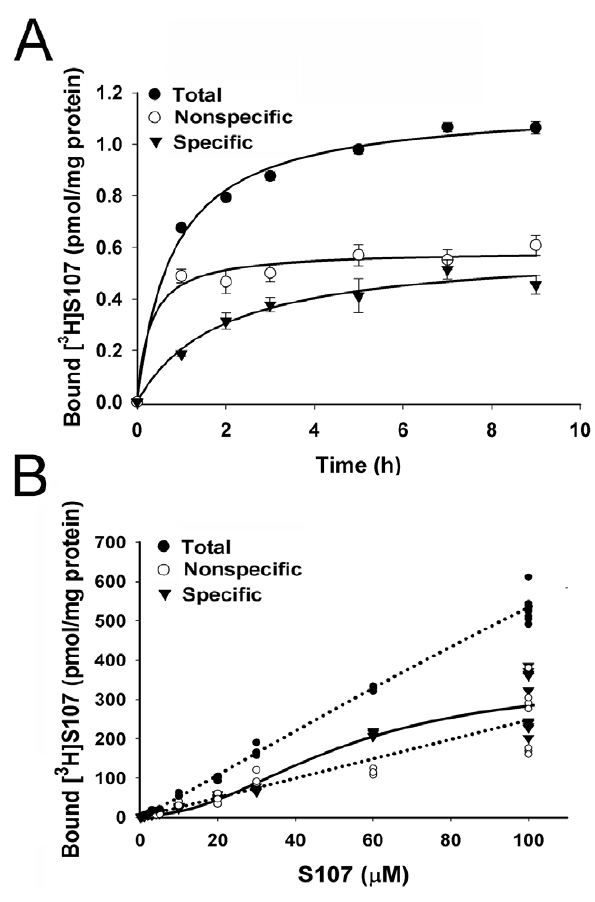
Figure 1. [ 3 H]S107 binding to SR vesicles. (A) Time course of total, nonspecific and specific [ 3 H]S107 binding to SR vesicles incubated with 0.2 m M [ 3 H]S107 in 0.25 M KCl, 20 mM imidazole, pH 7.0, 50 m M free Ca 2 + and protease inhibitors for 1 to 9 h at 24 u C. Nonspecific